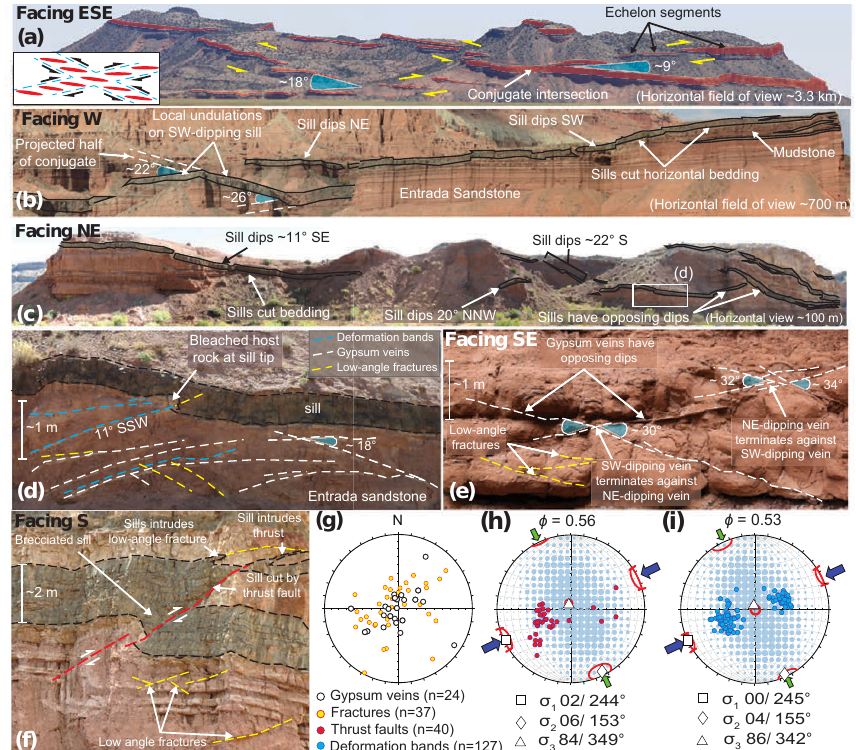
Figure 5. Sill geometry and paleostress analyses of deformation structures in the San Rafael subvolcanic field. (a) Kilometre-scale segmented sills show en-echelon stepping consistent with conjugate faults (sills shaded red). Inset shows schematic interpretation. (b) The 100m scale sills showing NE and SW dips (sills outlined in black). (c) The < 100m scale sills with bimodal dips (sills outlined in black). (d) Deformation bands and low-angle fractures parallel to gypsum veins. (e) Gypsum veins with conjugate geometries. (f) Sill intruding and cut by a thrust fault and low-angle fractures (sills outlined in black). (g–i) Lower-hemisphere equal-area projections showing (g) gypsum veins and fractures, (h) thrust faults, and (i) deformation band data; principal stress axes calculated for panels (h) and (i) using the right dihedra method (Delvaux and Sperner, 2003). Calculated stress axes given as plunge–trend measurements; φ value is the stress ratio ( σ 2 – σ 3 /σ 1 – σ 3 ).